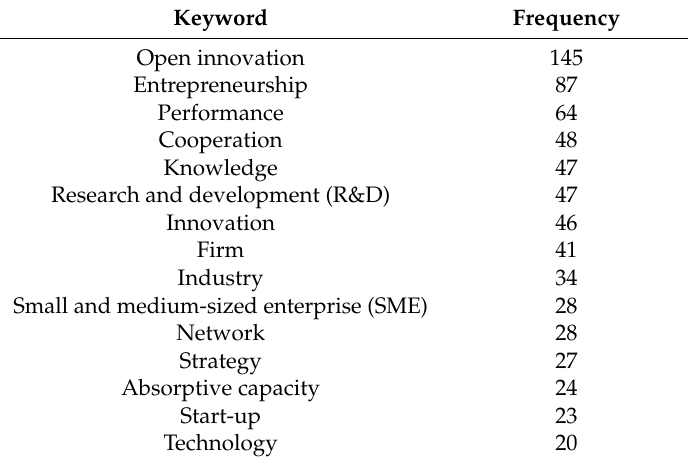
Table 7. Most frequent